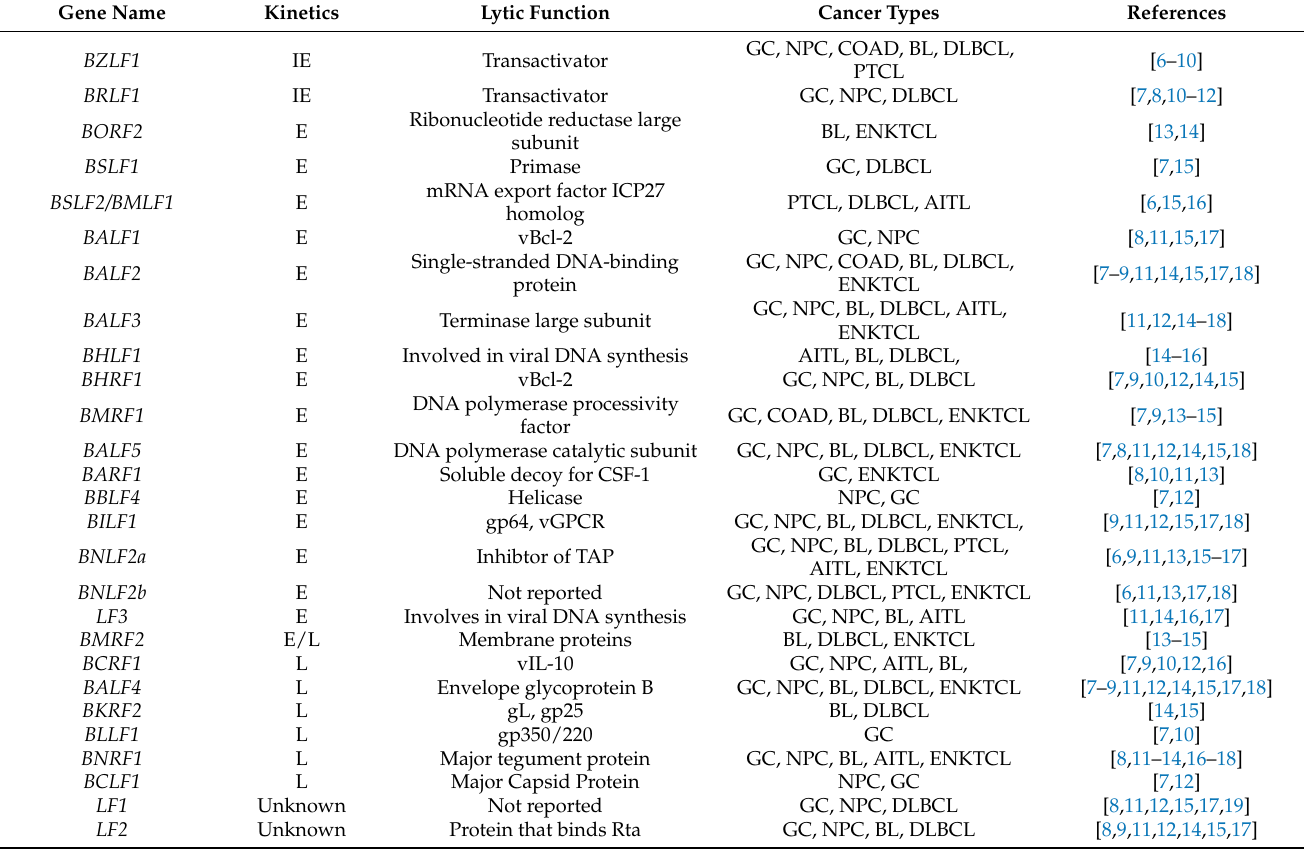
Table 1. Lytic genes that are detected in primary tissues of EBV-associated cancers by